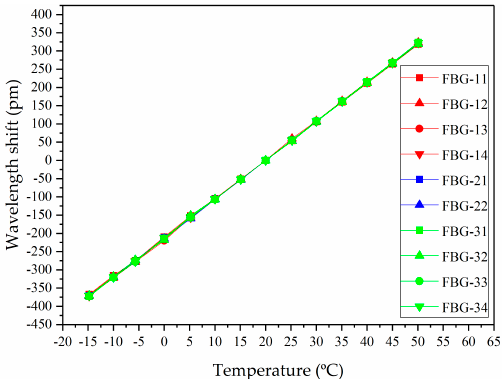
Figure 6. The relationship between temperature and wavelength shift of FBG embedded in the composite insulator.